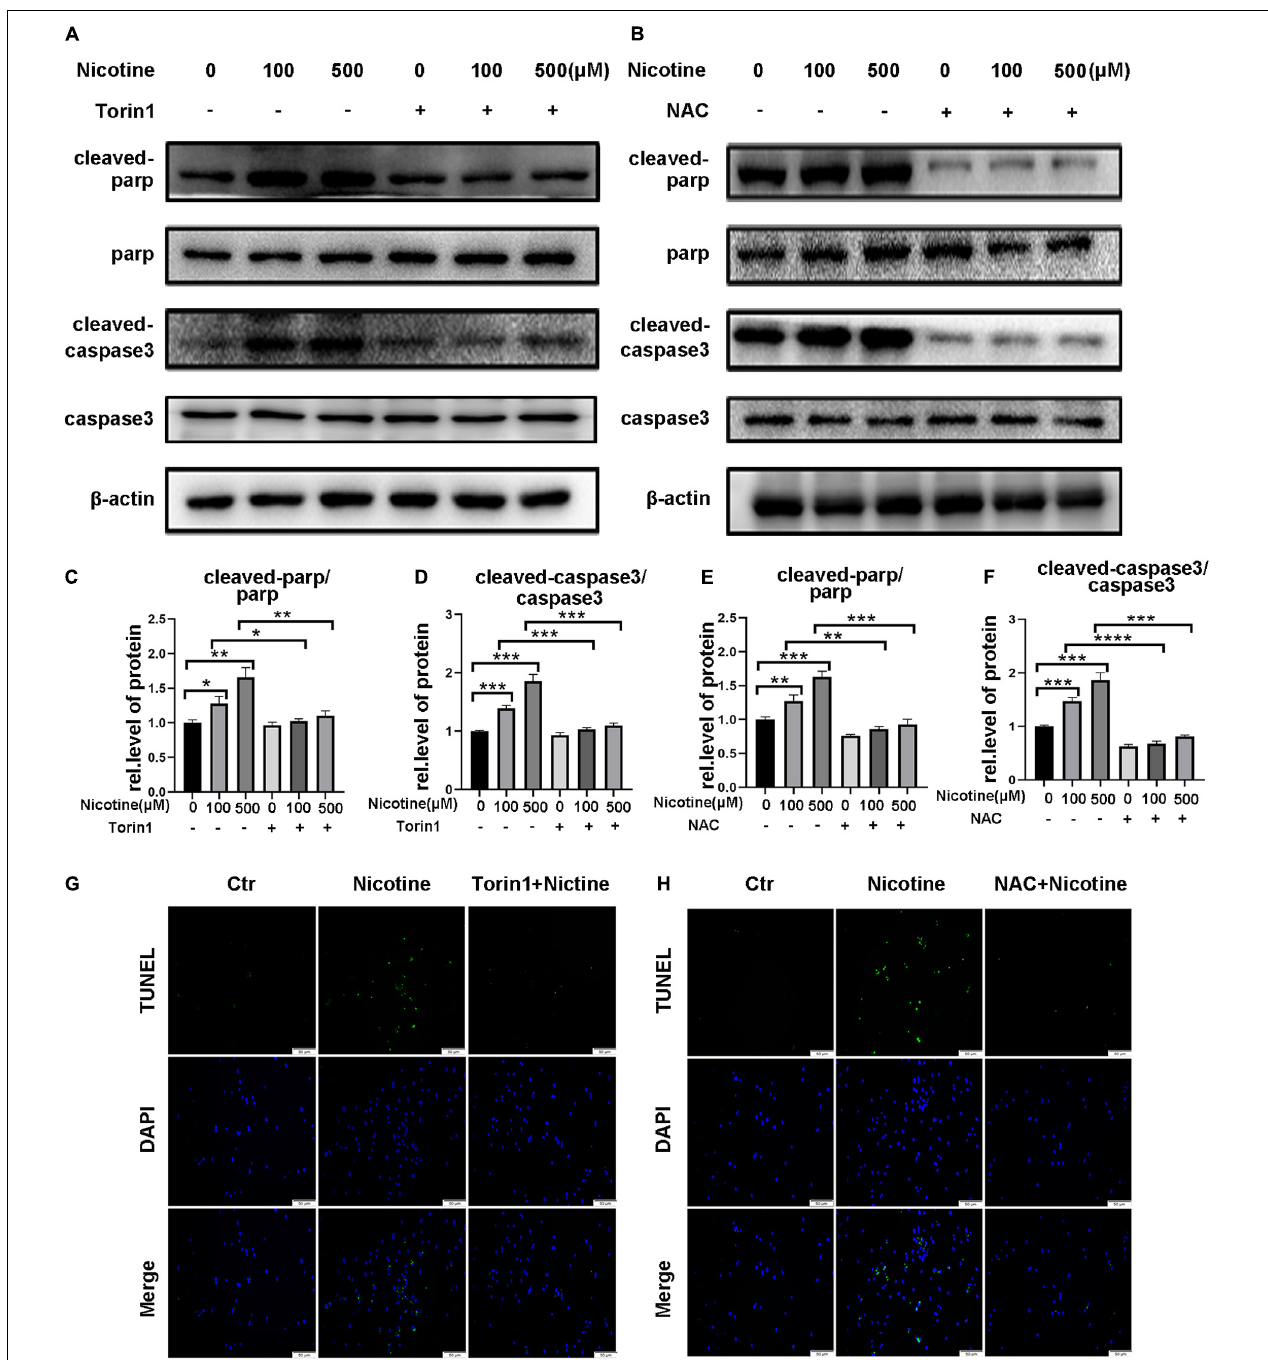
FIGURE 7 | Torin1 and NAC reduced the rate of myocardial apoptosis affected by nicotine. (A–F) Western blotting analysis and its quantification of apoptosis related protein. (**** p < 0.0001; *** p < 0.001; ** p < 0.01; * p < 0.05, n = 3). (G,H) TUNEL staining of NRVMs pretreated with Torin1 or NAC followed by nicotine exposure.